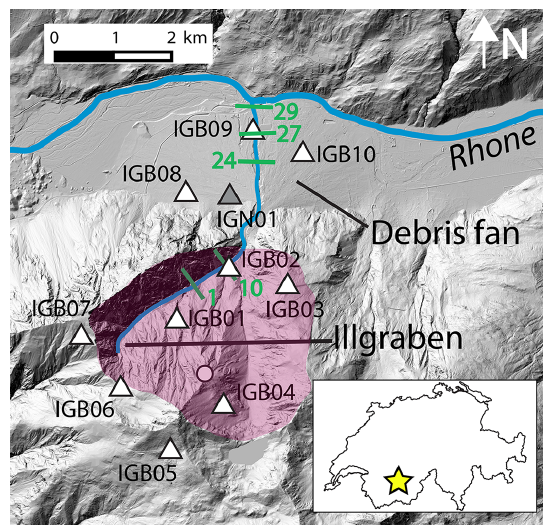
Figure 1. Illgraben region with its upper-catchment area (shaded polygon) and debris fan in the Rhône Valley. Numbered green lines represent check dams 1, 10, 24, 27 and 29; 2011 seismometer lo- cations are indicated by triangles (grey triangle represents the 2015 noise record station) and a WSL rain gauge is indicated by the cir- cle. The inset shows outlines of Switzerland and the yellow star marks the location of